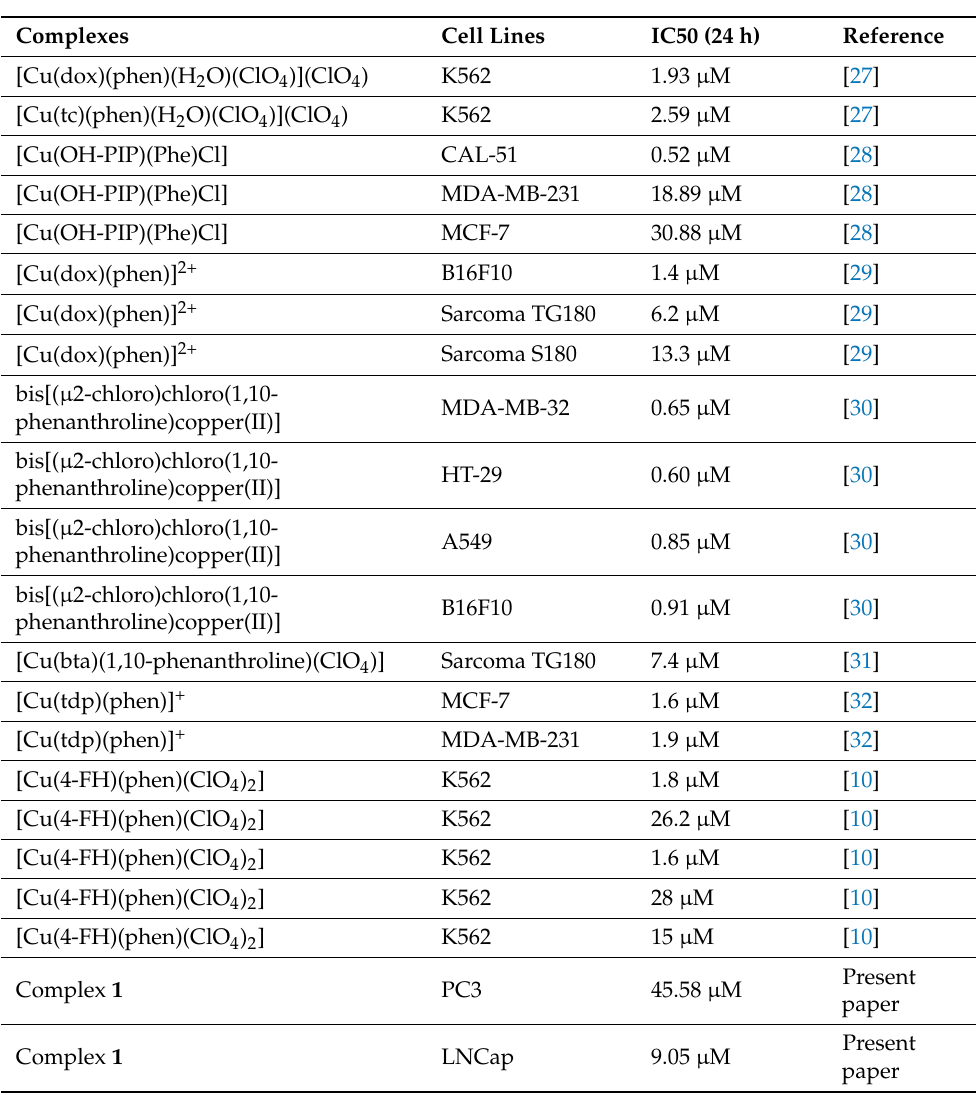
Table 2. Previous works with copper(II) complexes with N , N -donor ligands tested in different tumor cells compared with the results